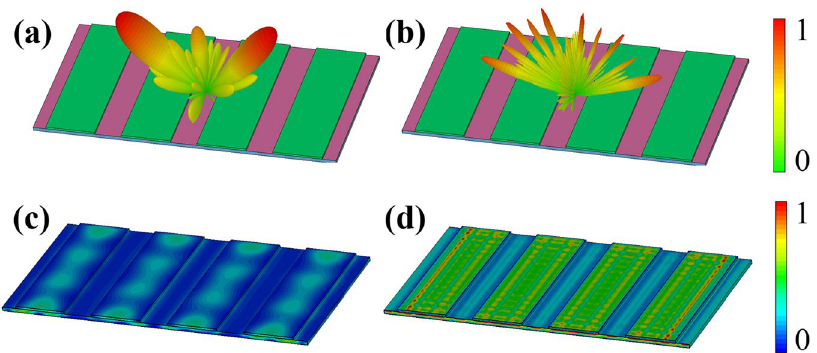
Figure 3. Full-wave simulation results of the proposed 1D grating integrated Salisbury screen under normal incidence of EM waves. The 3D scattering pattern at ( a ) 4.5 GHz and ( b ) 16 GHz. The power loss density distributions at ( c ) 4.5 GHz and ( d ) 16